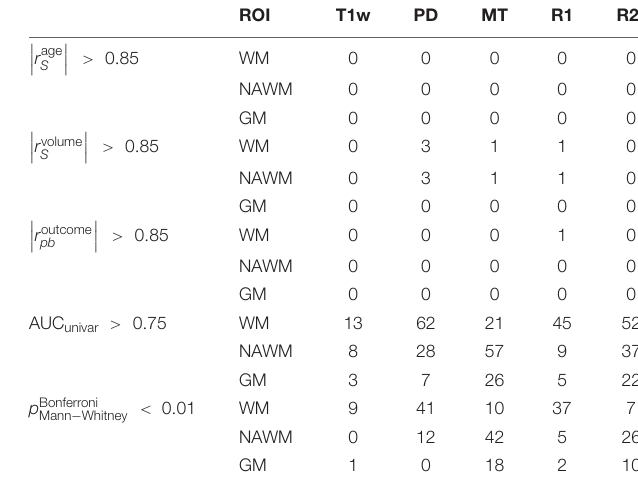
TABLE 4 | Number of features out of 1,395 with age, volume, and outcome correlations having an | rS| > 0.85 as well as univariate AUC > 0.75 and corrected Mann–Whitney p < 0.01 (listed in Supplementary Table 2